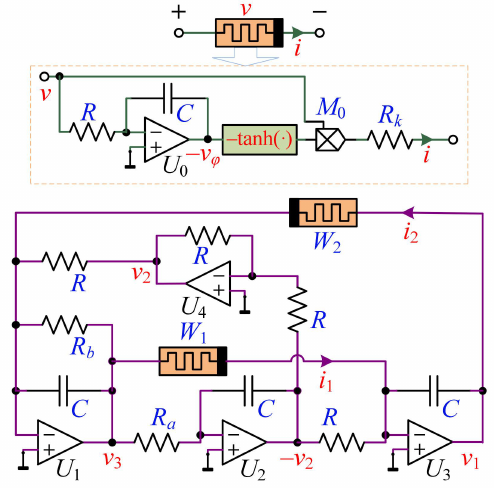
Figure 9. Analog implementation circuit in a jerk-circuit form for the 5-D TMJ system. The three initial capacitor voltages in the main circuit are preset as v 1 (0) = 1 nV, v 2 (0) = 0 V, and v 3 (0) = 0 V, and only the two initial capacitor voltages v 4 (0) and v 5 (0) of the memristor circuit modules are adjustable to acquire the desired phase portraits.